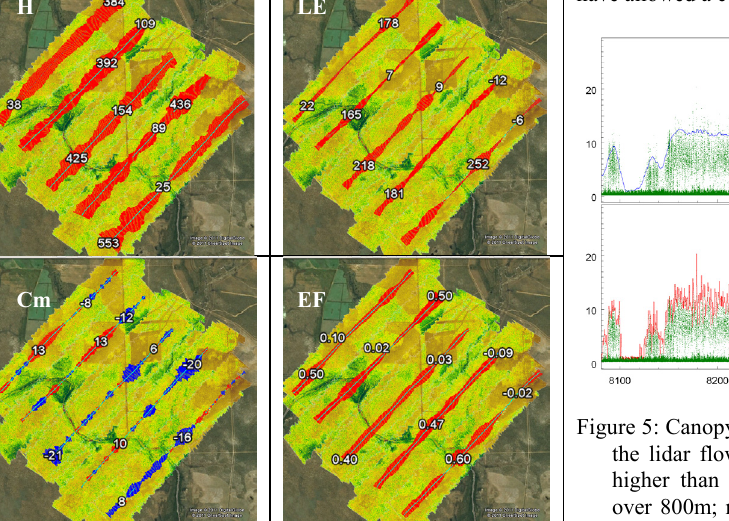
Figure 4: Aircraft flux grids (~20km) over the Daly River site (see Figure 3). For visualization, the fluxes were spatially averaged over 800m, their magnitude is illus- trated by the length of the coloured whiskers (red: up- ward fluxes, blue: downward fluxes). Minimum and maximum flux values are shown for each transect. H is sensible heat flux (W/m 2 ), LE is latent heat flux (W/m 2 ), Cm is flux of CO 2 (µmol CO 2 /m 2 /s), EF is evaporative fraction (LE/H+LE).The image beneath the fluxes is aircraft-derived NDVI using data from the ARA/AWI Tri-Spectral Scanner.